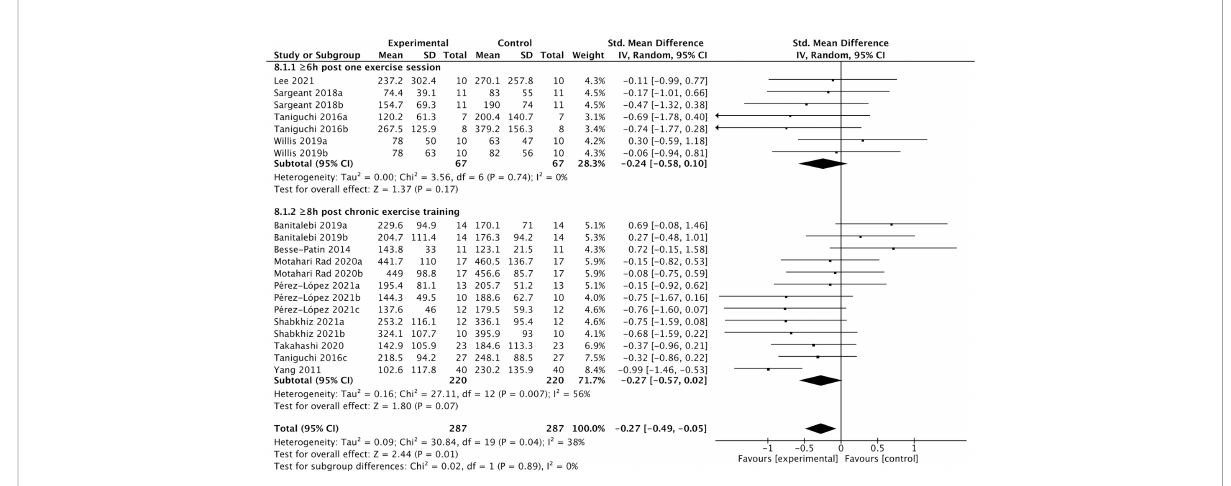
FIGURE 8 Forest plot of exercise effects on cFGF21 concentration sampled more than 6 hours postexercise. Random effect models were used as the pooling method. The mean value refers to the mean cFGF21 concentration in each group. cFGF21, circulating fi broblast growth factor